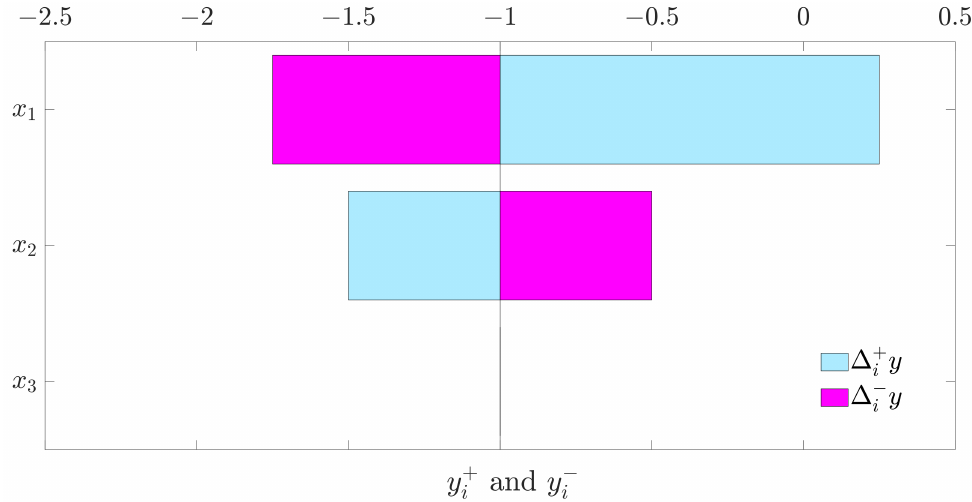
Figure 2. Tornado diagram for the toy example when the model inputs undergo a change of ± 50% with respect to the base case. The cyan bar quantifies ∆ + individually, to their upper limits. The magenta bar quantifies ∆ − model inputs, individually, to their lower